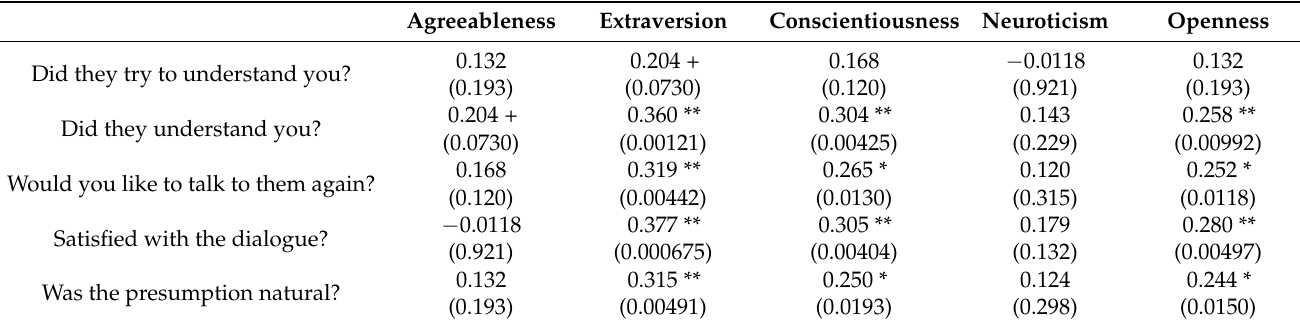
Table 11. Correlation coefficients between the percentage of correct answers for the estimated items and the questionnaire